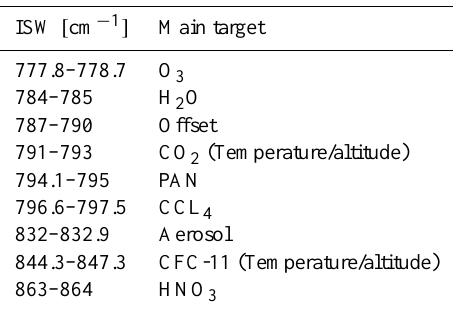
Fig. 2. CRISTA-NF spectra from detector LRS6, flight L5 pro- file 87 (black line). RFM calculation for the retrieval result is shown as black dashed line. Colored lines show the contribution of the most relevant trace gases to the result: CO 2 (green), O 3 (red), H 2 O (blue), CFC-11 (cyan), HCFC-22 (pink), HNO 3 (orange), CCL 4 (violet) and PAN (orchid). The contribution of Aerosol is shown as yellow, the instruments radiance offset as gold line. Grey and col- ored bars indicate the position of the integrated spectral windows (ISWs) used for the retrieval. The ISWs dominated by CFC-11 and CO 2 are highlighted in cyan and green, respectively. Table 1. Integrated spectral bands (ISWs) used and main target